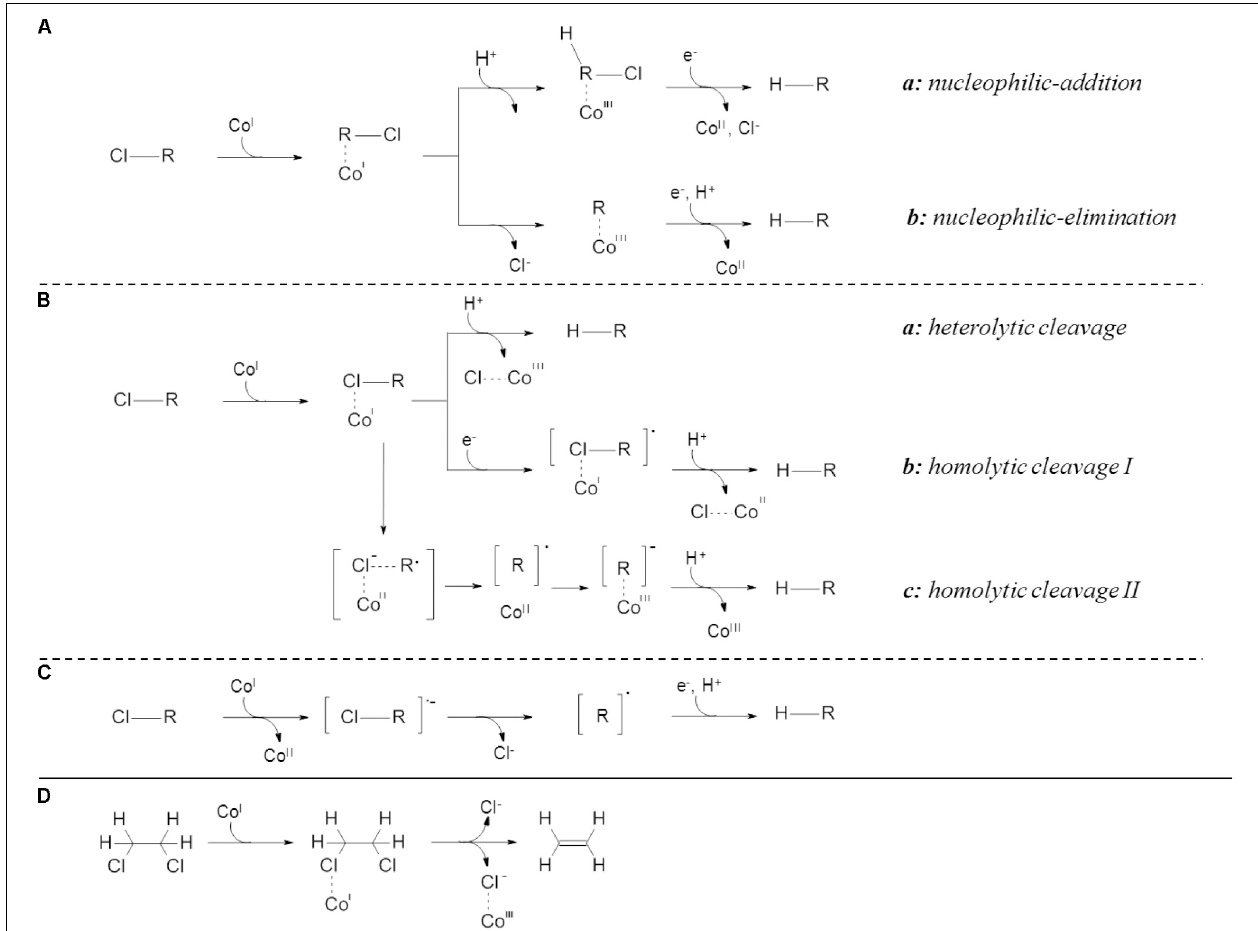
FIGURE 1 | Proposed mechanisms for reductive dehalogenation. (A) inner sphere two electron transfers, (B) inner sphere single electron transfers displaying different modes of bond cleavage, (C) outer sphere single electron transfer and (D) inner sphere single electron transfer for vicinally substituted compounds. Inner sphere two electron transfer (A) is further divided in nucleophilic-addition reaction (a) , characterized by initial protonation followed by carbon-halogen bond cleavage, and nucleophilic elimination (b) , possessing initial carbon-halogen bond cleavage with subsequent protonation of the remaining carbon (Heckel et al., 2018; Lihl et al., 2019). Inner sphere single electron transfers (B) are described as heterolytic (a) or homolytic (b,c) cleavage (Cooper et al., 2015; Payne et al., 2015). Two distinct mechanisms of homolytic cleavage are proposed leading either to abstraction of a cobalt-halogen complex (Cooper et al., 2015; Payne et al., 2015) (b)